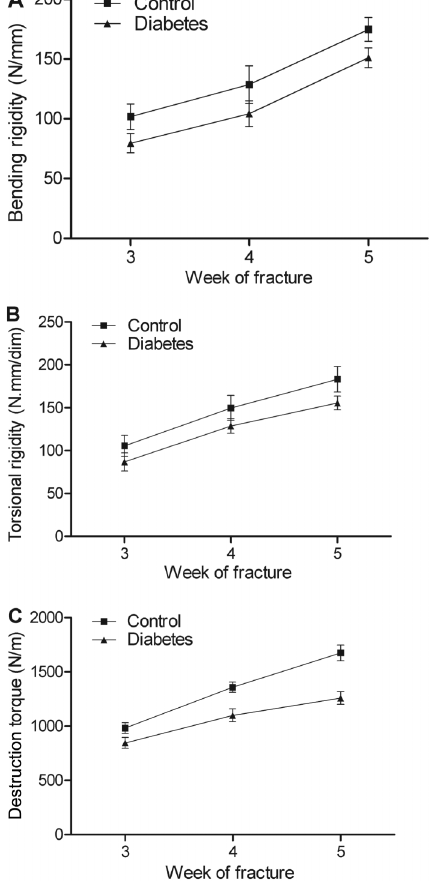
Table 1 . Primer sequences for qPCR.